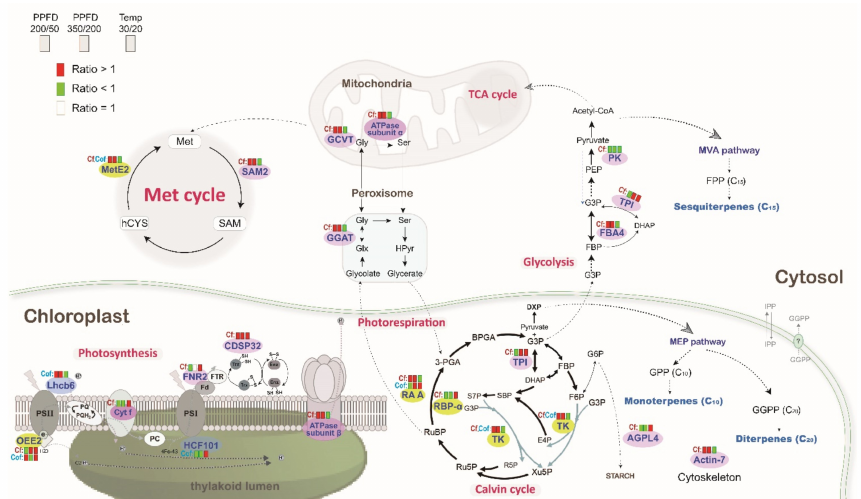
Figure 5. Schematic presentation of different expressed proteins of C. formosensis (Cf) and C. obtusa var. formosana (Cof) under different light intensities and growth temperatures, as shown in Tables S2 and S3. Abbreviations: AGPL4, Glucose-1-phosphate adenylyltransferase large subunit 4; BPGA, 1,3- Bisphosphoglycerate; CDSP32, Thioredoxin-like protein CDSP32; Cyt f, Cytochrome f; DHAP, Dihy- droxyacetone phosphate; DXP, 1-Deoxy-D-xylulose 5-phosphate; E4P, Erythrose 4-phosphate; F6P, Fructose 6-phosphate; FBA4, Fructose-bisphosphate aldolase 4; FBP, Fructose 1,6-bisphosphate;